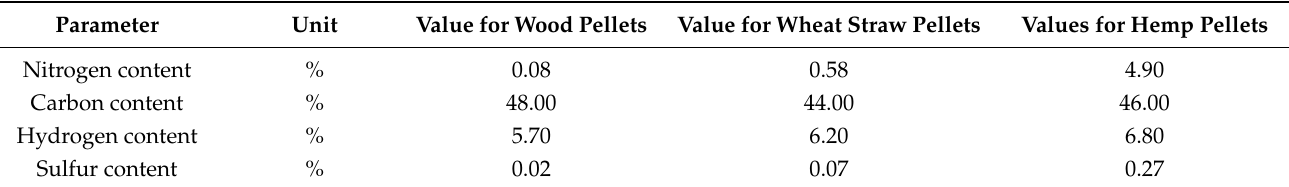
Table 8. Biomass fuels’ elemental analysis